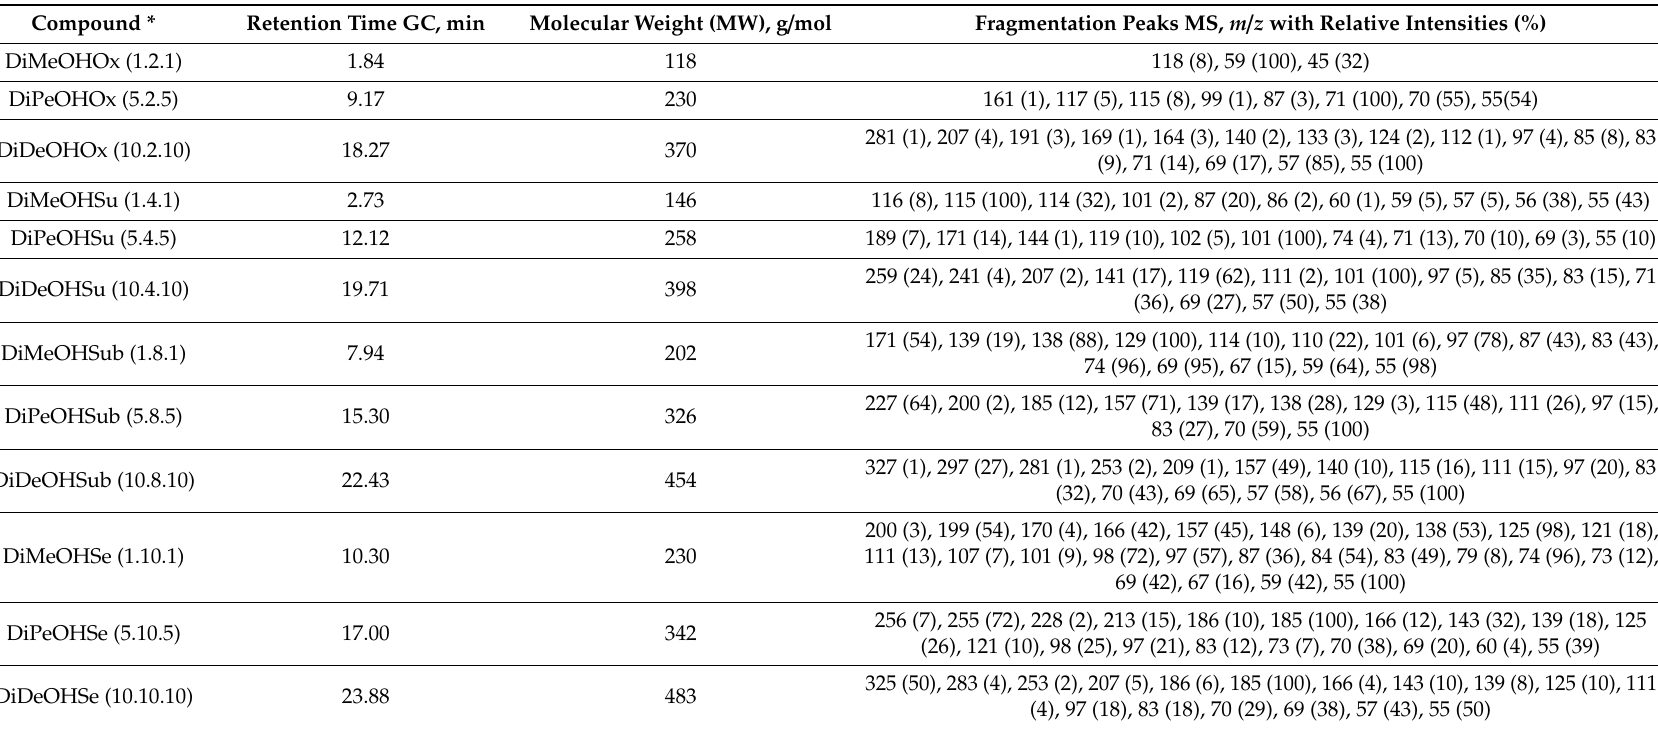
Table 1. Data obtained from the gas chromatograms and mass spectra of the diesters through GC-MS